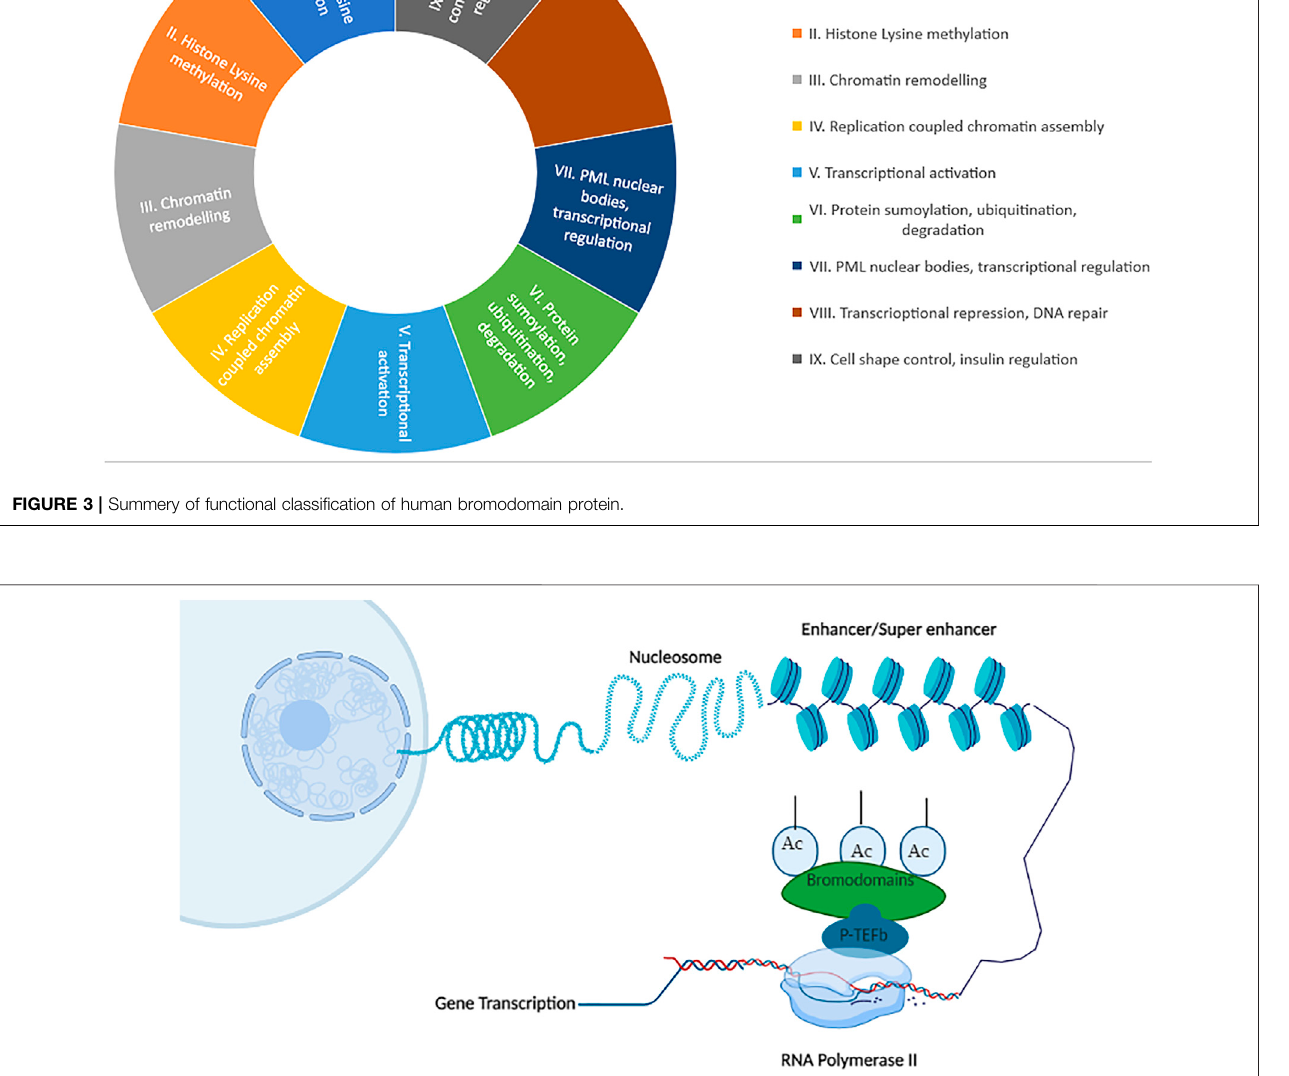
FIGURE 4 | P-TEFb complex-associated gene transcription: BET bromodomain proteins (BRD4, BRDT) recruit positive transcription elongation factor b (P-TEFb) transcription factor at RNA polymerase II leading to phosphorylation of RNA Pol II, which results in gene transcription and elongation. Created with BioRender.com.